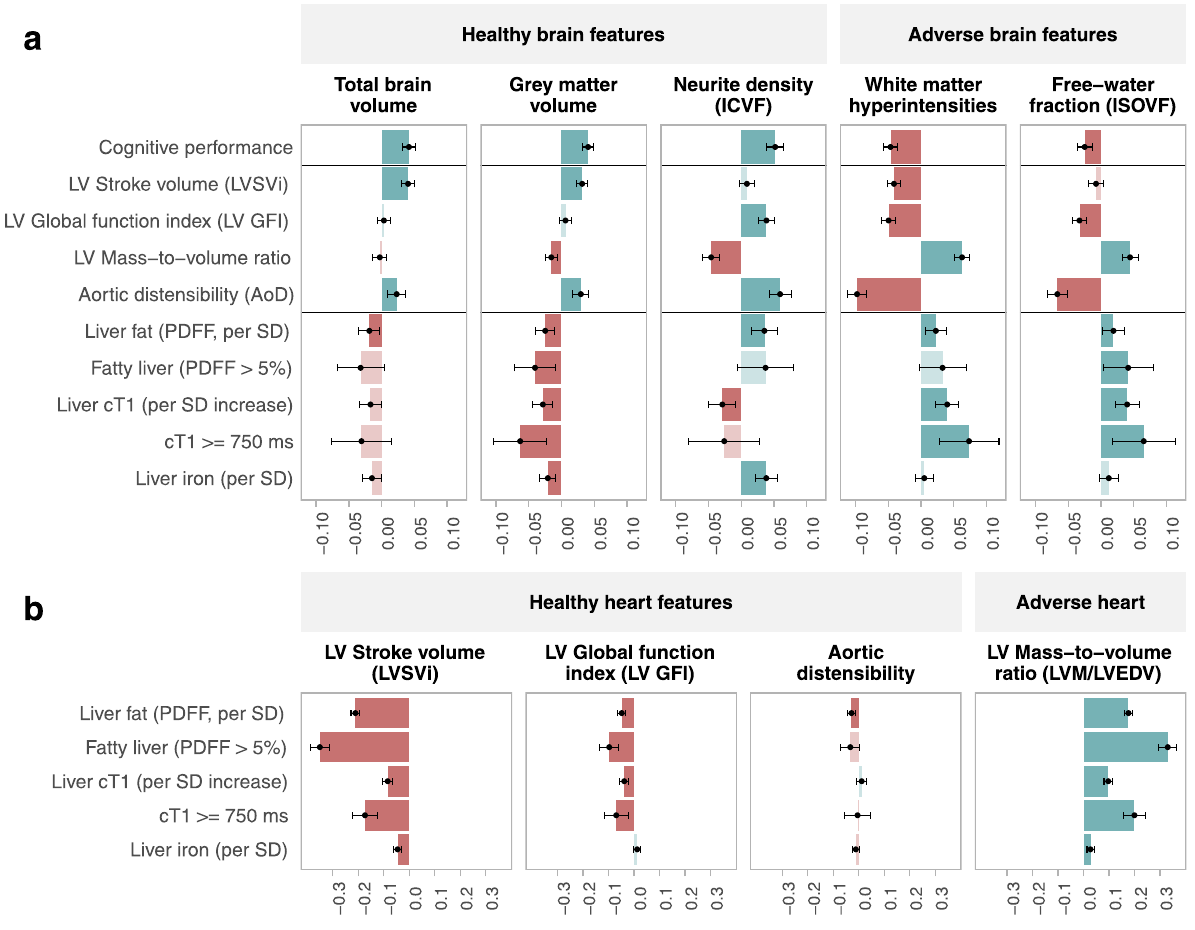
Fig. 3 | Pairwise associations between imaging phenotypes of the heart, brain and liver. Size of the bars and interval centre dot represent standardised beta coef fi cients, error bars represent 95% con fi dence intervals for the standardised beta coef fi cient from multivariable linear regression models. Red bars re fl ect negative associations, green bars re fl ect positive associations. a Heart and liver imaging metrics in pairwise associations with brain imaging metrics. b Pairwise associations between liver and heart imaging metrics. Models are adjusted by age, sex, diabetes, hypertension, BMI ≥ 30kg/m2, high cholesterol, smoking, physical activity, alcohol consumption, deprivation, educational level, red blood count, total cholesterol, and glycosylated haemoglobin. Brain analyses are additionally adjustedbyheadsize,imagingsite,scannercoordinatesanddateofscanning.Each barisfromaseparatemodel.Coef fi cientsigni fi canceisassessedwithatwo-sidedT- test,and p -values wereconsidered signi fi cant afteradjustment formultiple testing